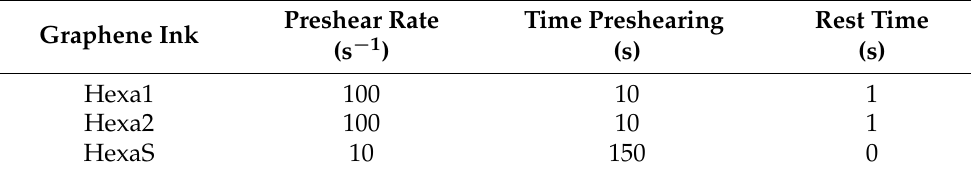
Figure 1. Experimental devices used for the measurement of the surface tension, i.e., ( a ) a Sigma 700 Biolin Scientific equipped with a Du Noüy ring, and the rheological characterization of the commercial graphene inks, i.e., ( b ) an Anton Paar MCR301 and ( c ) a CaBER-1. Table 2. Values of the parameters of the preshear protocol imposed on each